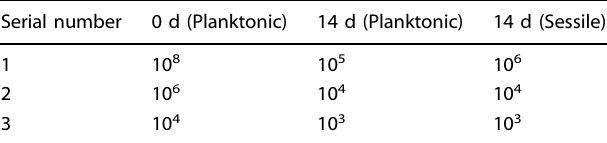
Table 1. The pores count of A. terreus (planktonic, pores mL − 1 ; sessile, pores cm − 2 ) initially and after 14 days of testing.